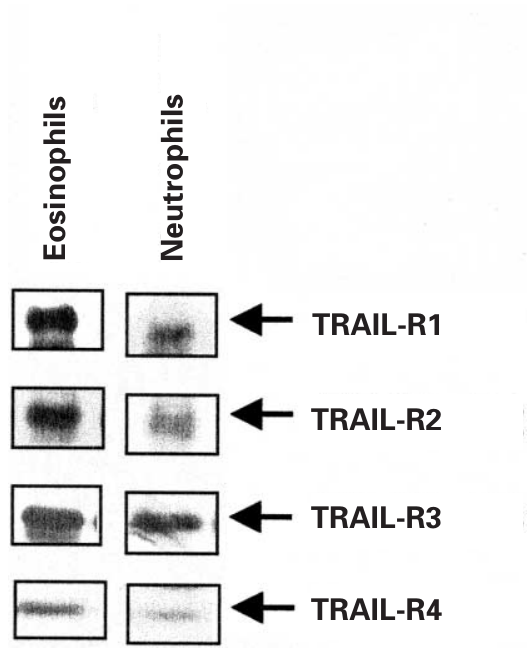
Figure 1 TRAIL receptor mRNAs are expressed by granu- locytes. mRNAs for TRAIL-R1, TRAIL-R2, TRAIL-R3, and TRAIL- R4 were detected in both eosinophils and neutrophils using RT-PCR. These results are representative of three independent